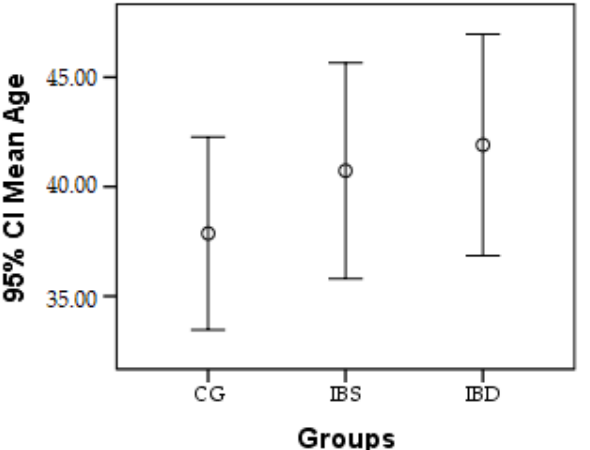
Figure 1. Age distribution by study group, where, dots represent the mean age in each group. The large standard deviation shows a variety of age in all 3 research groups.